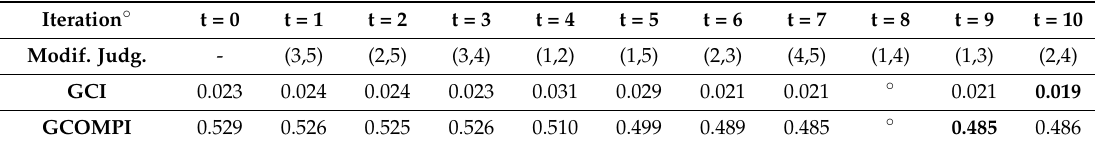
Table 8. Results for the iterative procedure with θ = 0.25 (the best value of the methods is in bold, for each indicator).